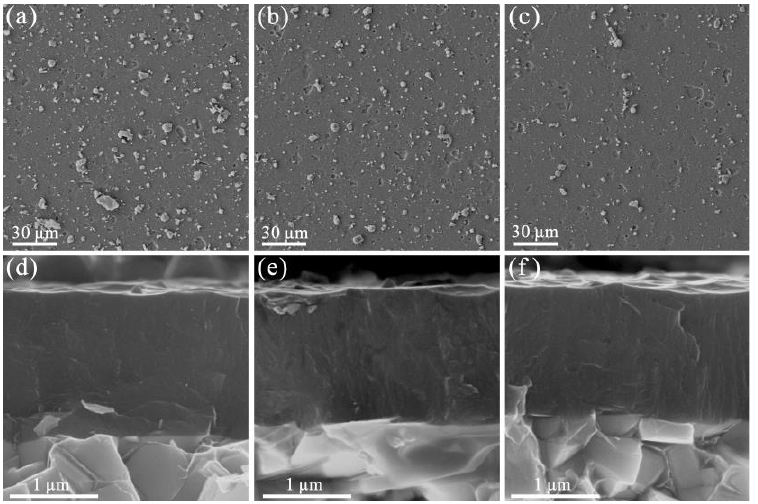
Figure 2. SEM surface and cross-sectional morphologies of as-deposited ( a , d ) Ti 0.88 Si 0.12 N, ( b , e ) Ti 0.88 Si 0.08 W 0.04 N, and ( c , f ) Ti 0.84 Si 0.09 W 0.07 N coatings.